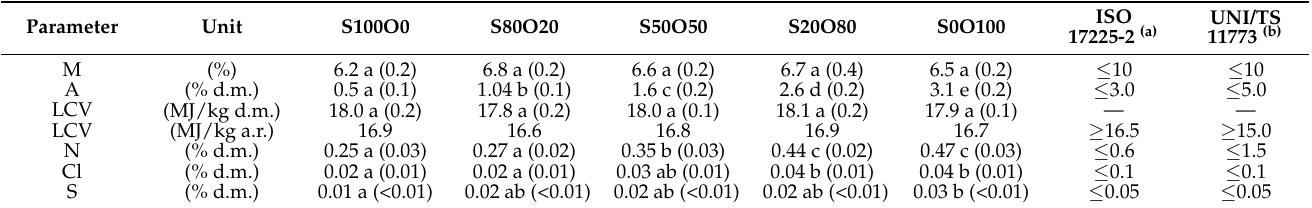
Table 4. Results of analyses carried out on pellets produced with the different blends of spruce sawdust and olive pruning residues (average values with standard deviation in parenthesis).